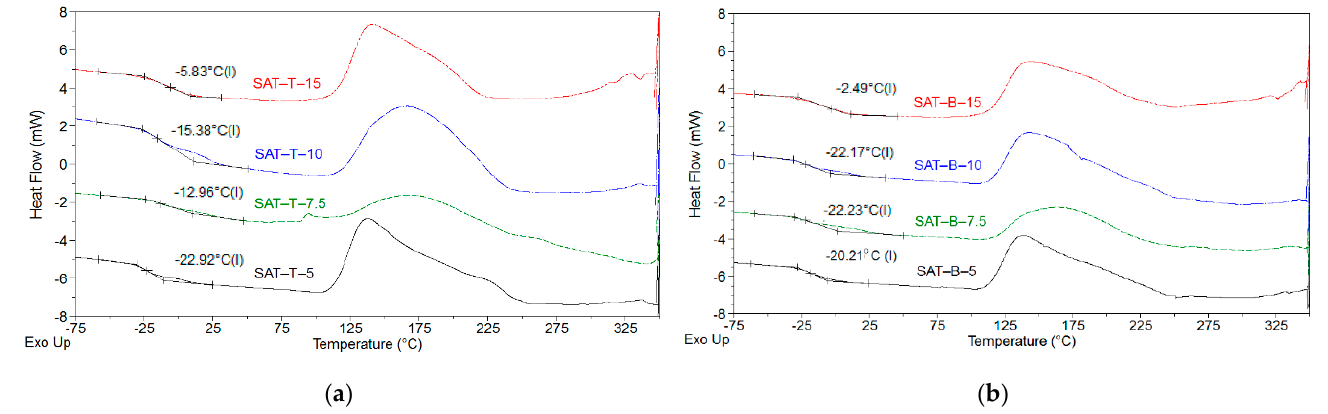
Figure 5. DSC thermographs for UV-crosslinked SATs based on MAT-T ( a ) or MAT-B ( b ).